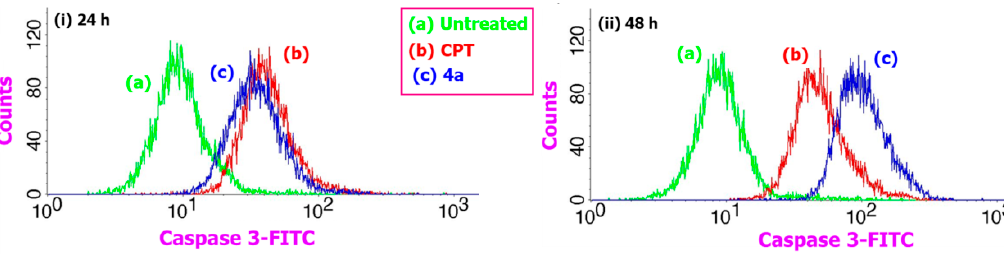
Figure 9. Overlay of fluorescence spectrums for the compound 4a induced A549 cells with that of positive and negative controls during the two different intervals of 24 h (i) and 48 h (ii).